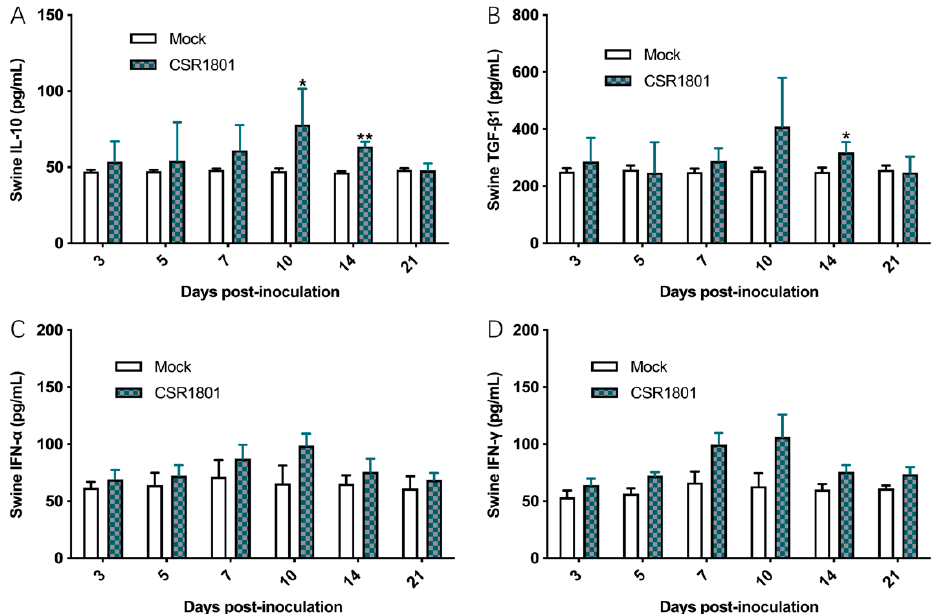
Figure 5. Levels of cytokines in peripheral blood of piglets collected at serial timepoints (0, 3, 5, 7, 10, 14, and 21 dpi). The piglets in group 1 ( n = 5) were all nasally inoculated with 2 mL/pig of the PRRSV CSR1801 strain at a dose of 1 × 10 5 TCID 50 . The piglets in group 2 ( n = 5) were inoculated with the cell culture medium as the mock ‐ inoculated control. The concentrations of swine IL ‐ 10 ( A ), TGF ‐β 1 ( B ), IFN ‐α ( C ), and IFN ‐γ ( D ) were determined by the commercial ELISA kit. Each point represents the mean value (±SD) generated from all pigs in one group at the indicated timepoints post ‐ inoculation. * p < 0.05; ** p < 0.01.